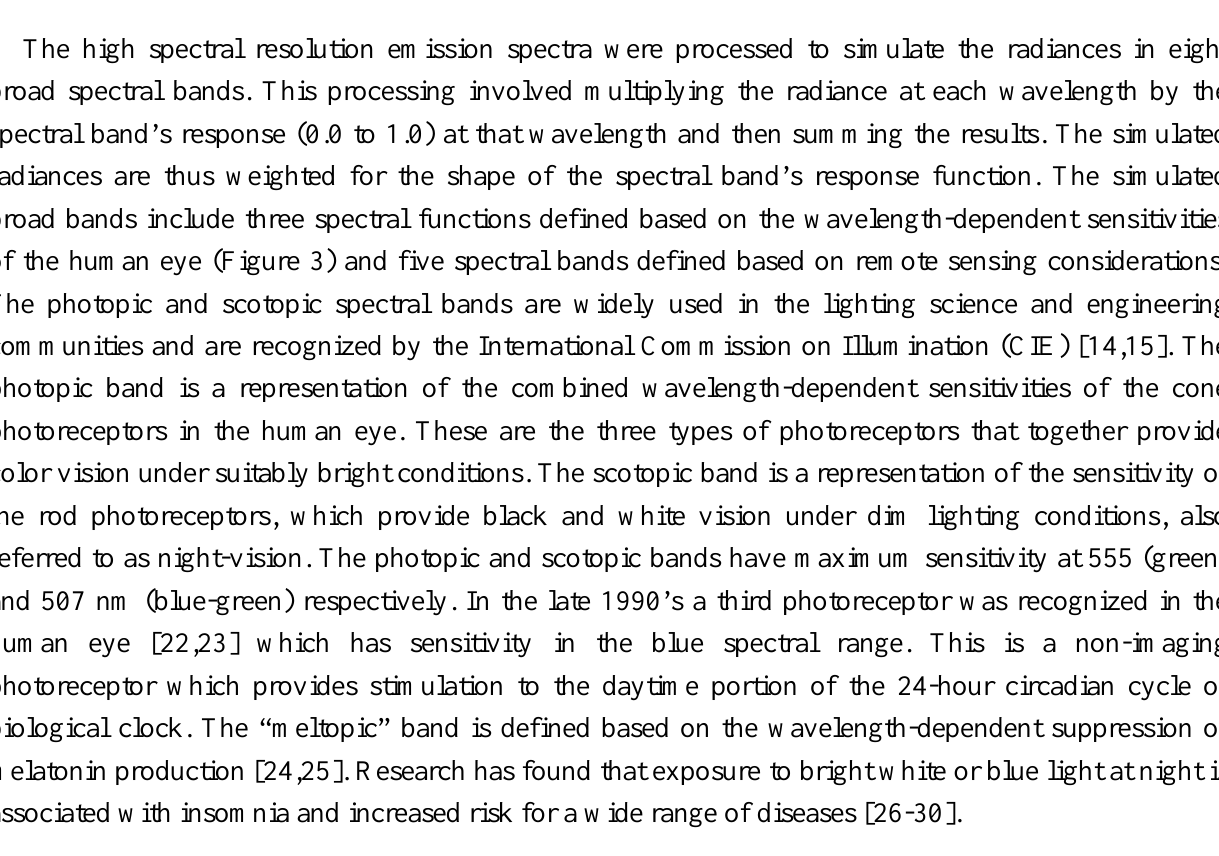
Figure 3. Spectral response functions of the three human photoreceptor